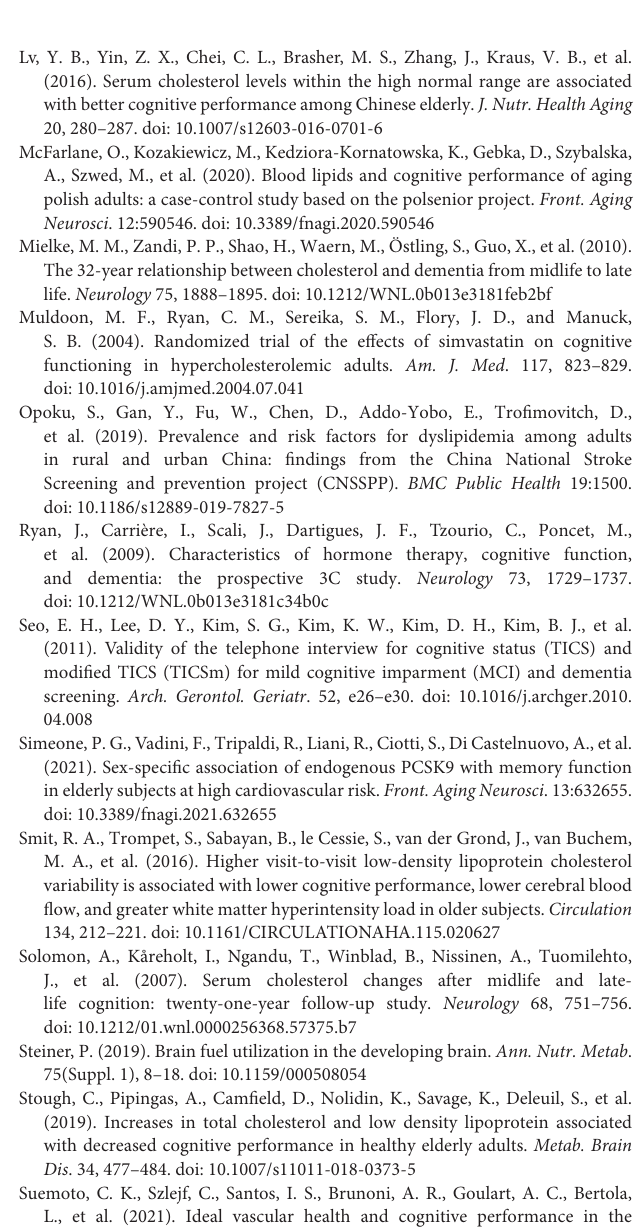
Supplemental Table 5 | The OR (95% CI) between cholesterol variation and cognitive decline in participants with or without cardiovascular disease. Supplemental Table 6 | The OR (95% CI) between cholesterol variation and cognitive decline in participants just with hypertension and with heart problems or